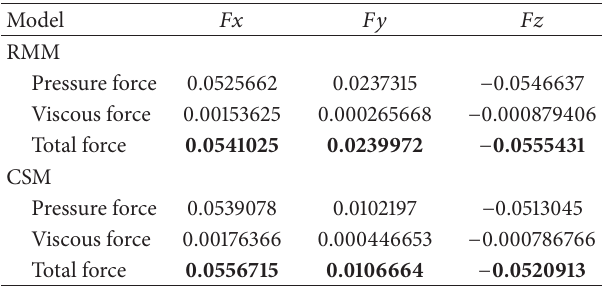
Figure 9: Histogram comparing the decomposed forces of pressure force acting on the models’ surfaces. Table 4: The surface resistances of each model on the original coordinate system.